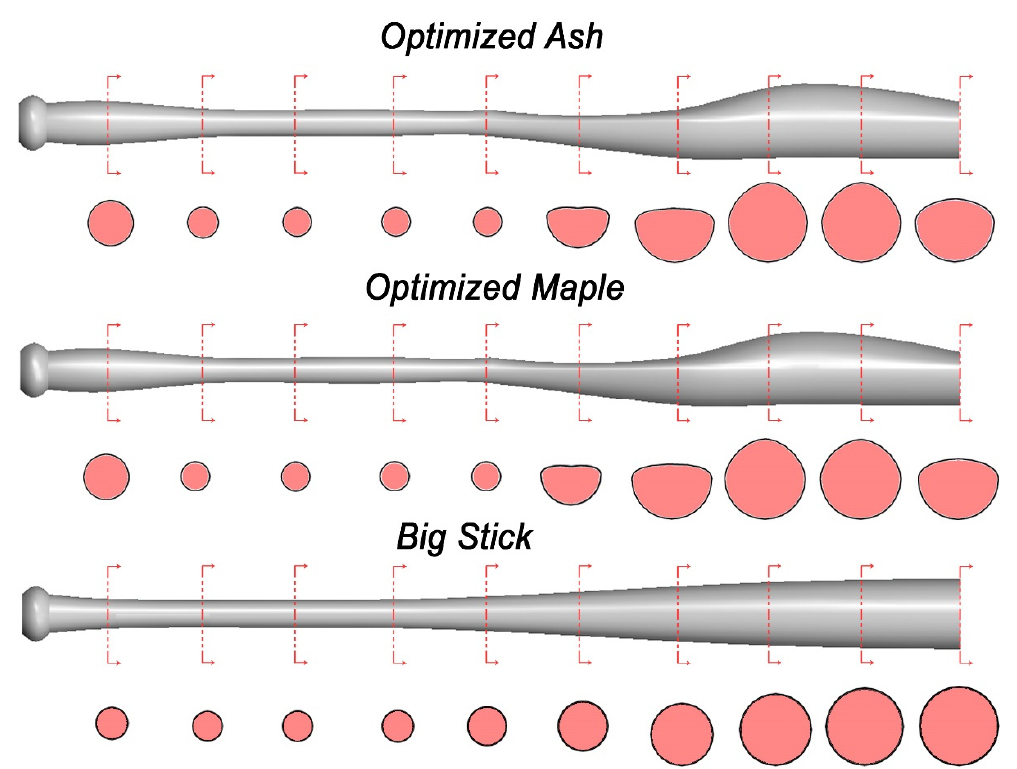
Figure 10. Variation of cross-sections of the bats along their lengths. The cross-sections are below the bats and shown in red.